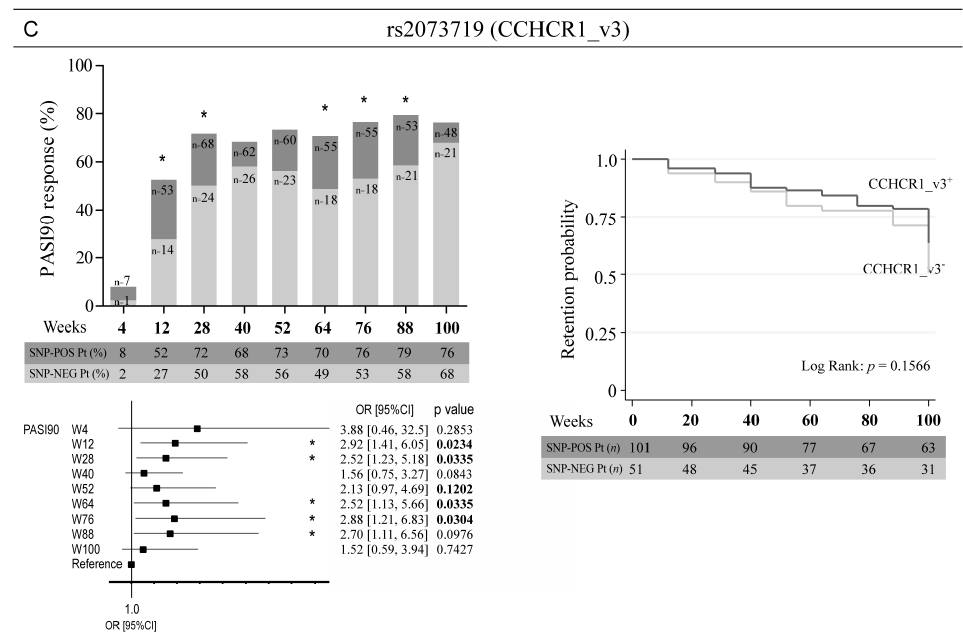
Figure 4. Association analysis between clinical response to ustekinumab and SNPs in LCE3A-B (rs12030223, rs6701730), CDSN (rs1042127, rs4713436) and CCHCR1 (rs2073719). ( A ) Patients carrying out rs12030223 or rs6701730 SNPs in LCE3A-B (LCE3A-B v1_v2) (dark grey bars) showed a better response to ustekinumab than SNP-negative patients (light grey bars), with the achievement of PASI90 and PASI100 at the indicated time-points of observation. ( B ) Vice versa the absence of the rs1042127 (CDSN_v2) and rs4713436 (CDSN_v5) (light grey bars) determined PASI90 and PASI100 achievement, as compared with SNP-positive patients (dark grey bars). ( C ) Rs2073719 (CCHCR1_v3)-positive patients (dark grey bars) reached a significant better response to ustekinumab than SNP-negative subjects (light grey bars). Rs12030223 and rs6701730 ( A ) as well as rs1042127 and rs4713436 ( B ) showed the same pattern of presence/absence in the psoriatic population and, thus, identical logistic regression curves. Numbers in the bars indicate the exact number of subjects carrying or not the alleles. The tables under the graphs show the percentage of patients (Pt) carrying (SNP ‐ POS) or not carrying (SNP ‐ NEG) the relevant alleles. * p values < 0.05 were considered significant. Regression analyses are also summarized in forest plots ( A ‐ C ). Squares on the x ‐ axis shows OR estimates for each observation point and the error bars represent 95% CI. * p values < 0.05 were considered significant and indicated in bold font. Graphs of comparison between retention probability curves of rs12030223/rs6701730 ( A ), rs1042127/ rs4713436 ( B ) and rs2073719 ( C ) are shown. The tables under the graphs show the number of patients (Pt) carrying (SNP ‐ POS) or not carrying (SNP ‐ NEG) the relevant alleles. * p values <0.05 were considered significant.